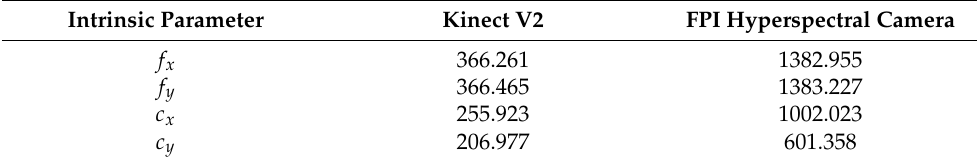
Table 1. The estimated intrinsic parameters of the cameras during the calibration.